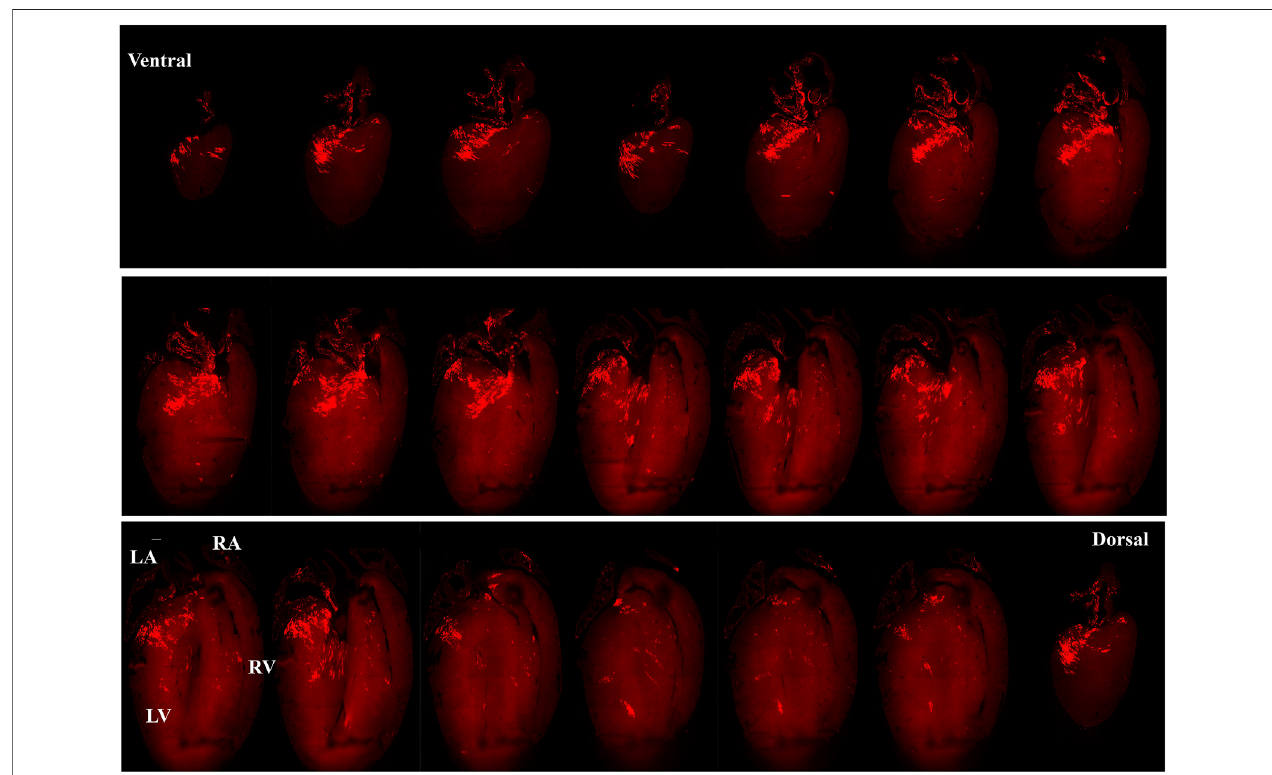
FIGURE 5 | Selected representative coronal sections from an adult Pnmt Cre/ChR2 − tdTomato mouse heart showing the distribution of PdCMs from ventral side to dorsal side. Scale bar: 1,000 μ